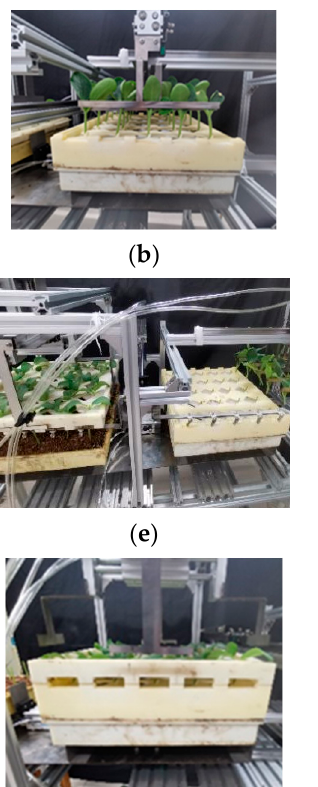
Figure 13. Whole-plate grafting test prototype.